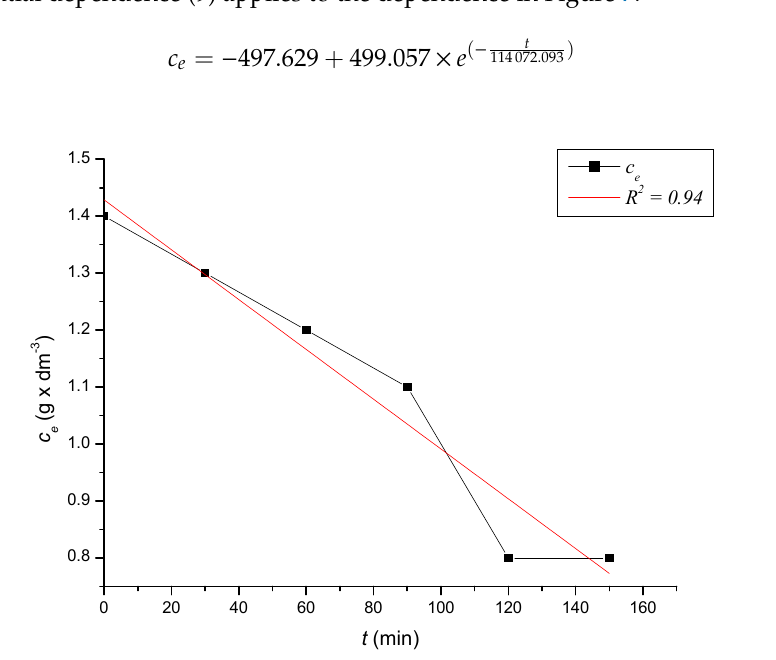
Figure 7. The kinetic course of reducing the concentration of Fe 3+ cations in a solution with an initial concentration of 1.40 g × dm −3 by the action of clinoptilolite.